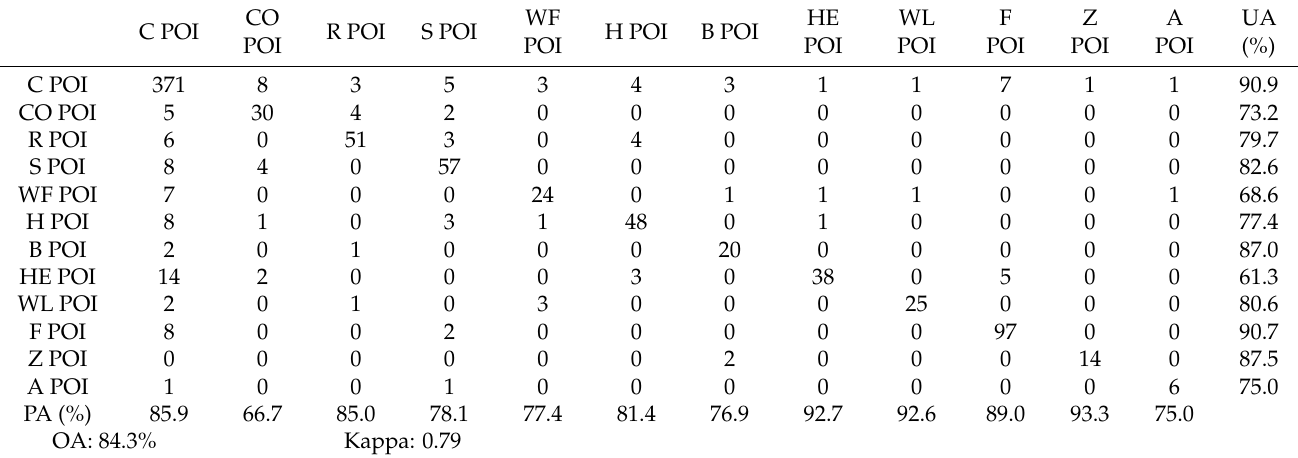
Table 7. The confusion matrix was used to calculate POI classification accuracy.